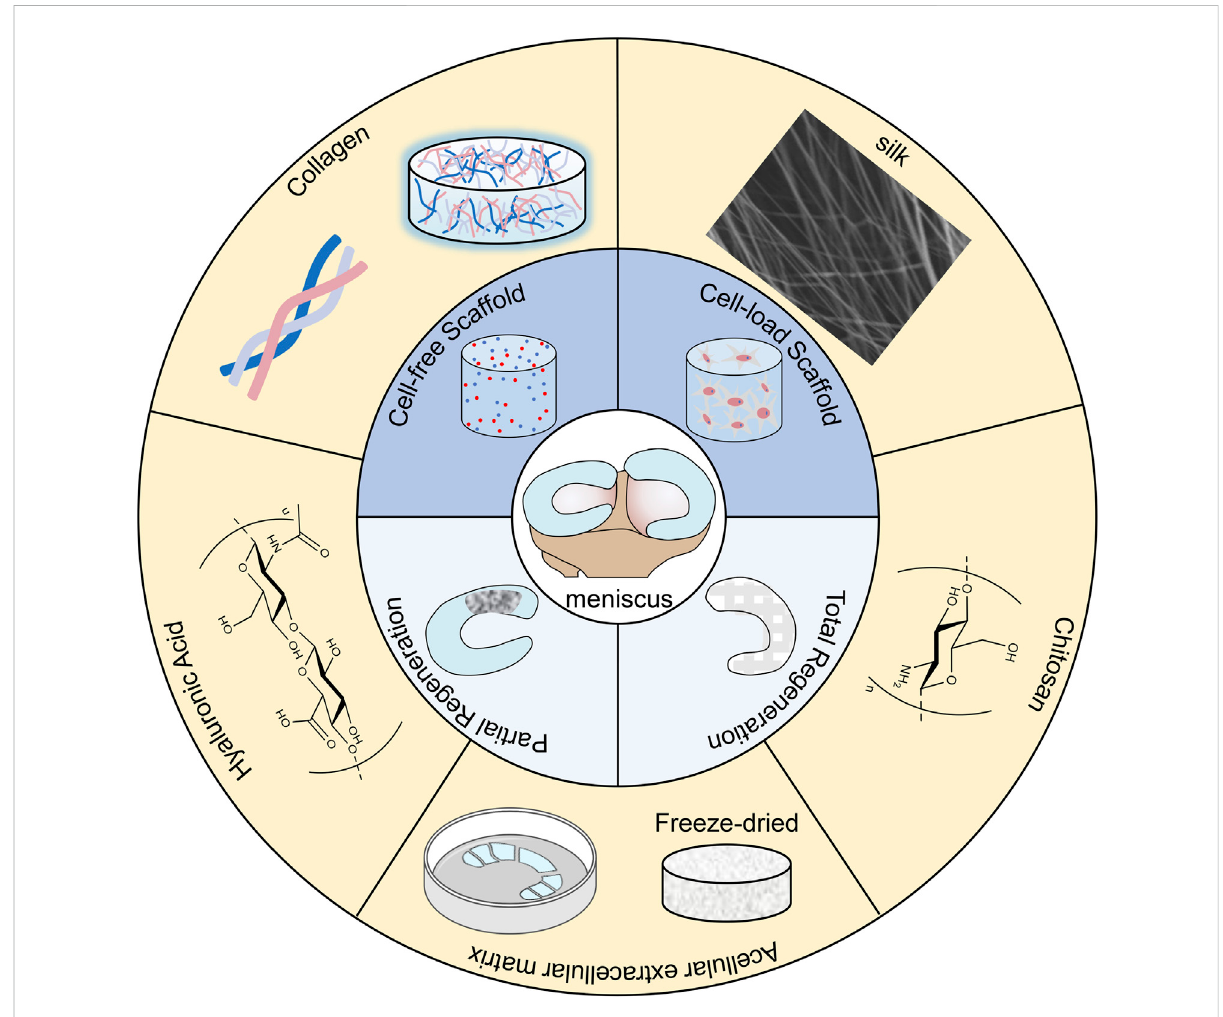
FIGURE 1 Schematic illustration of natural materials for meniscus tissue